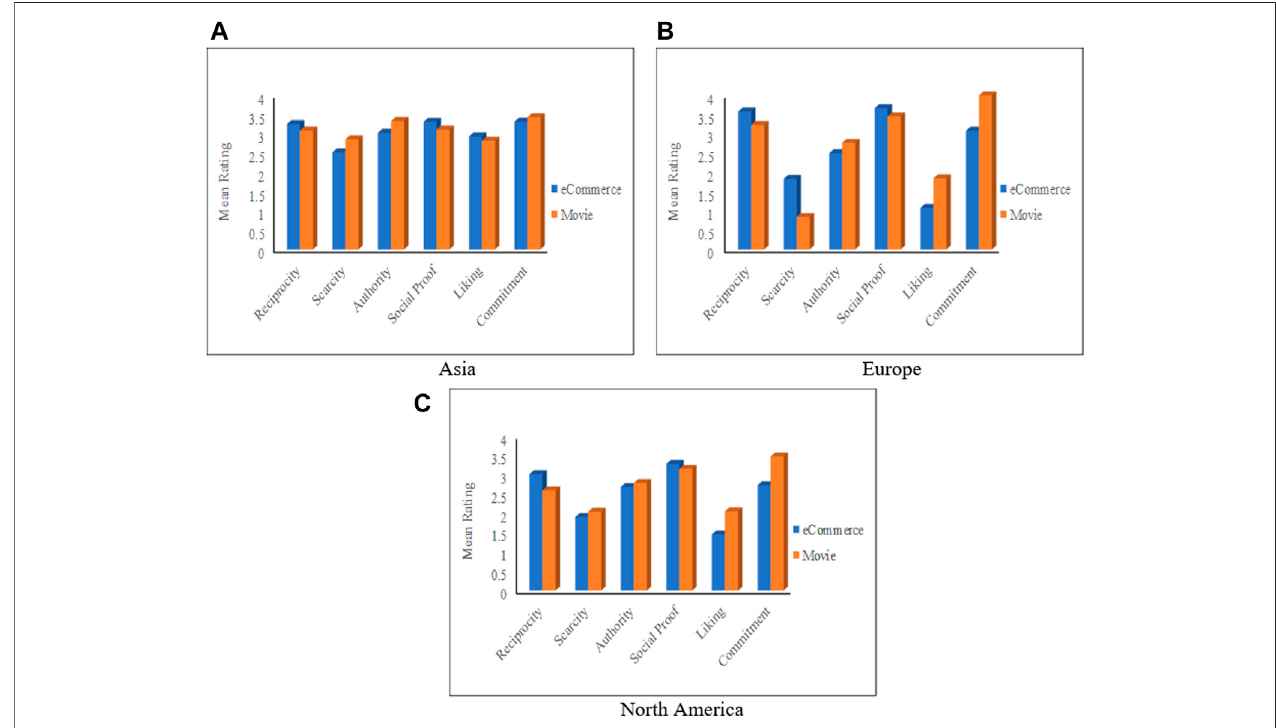
FIGURE 9 | Mean rating based on the continent and the application domain. (A) Asia, (B) Europe, (C) North America.